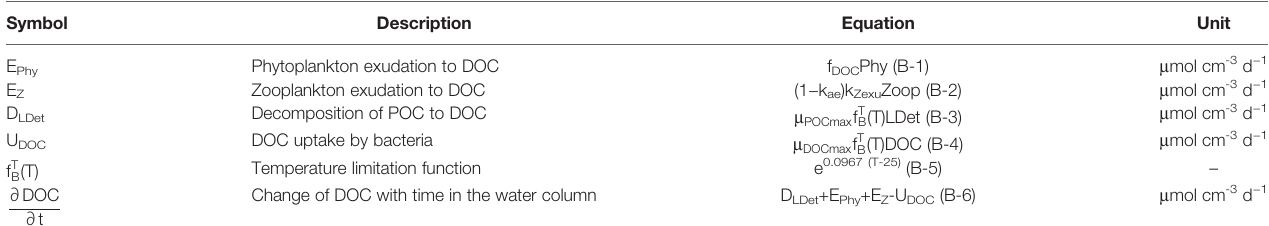
TABLE 6 | Model equations for DOC source and sink terms in the biogeochemical model. Symbol